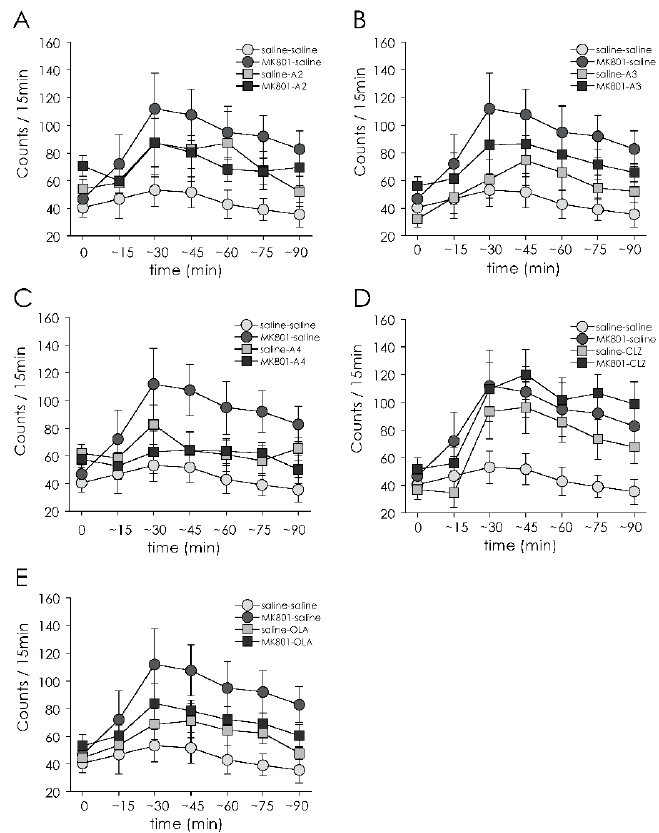
Figure 5. Effect of 14-day (PD 43–56) treatment with apocynin-tandospirone derivatives and an- tipsychotics on MAP-induced vertical activity (for 90 min) on PD 57. Data with A-2 ( A ), A-3 ( B ), A-4 ( C ), CLZ ( D ) and OLA ( E ) are shown. Saline-saline group ( n = 12), MK801-saline group ( n = 12), saline-A2 group ( n = 12), MK801-A2 group ( n = 13), saline-A3 group ( n = 12), MK801-A3 group ( n = 12), saline-A4 group ( n = 13), MK801-A4 group ( n = 13), saline-CLZ group ( n = 12), MK801-CLZ group ( n = 12), saline-OLA group ( n = 12), and MK801-OLA group ( n = 12). Values are expressed as means ±